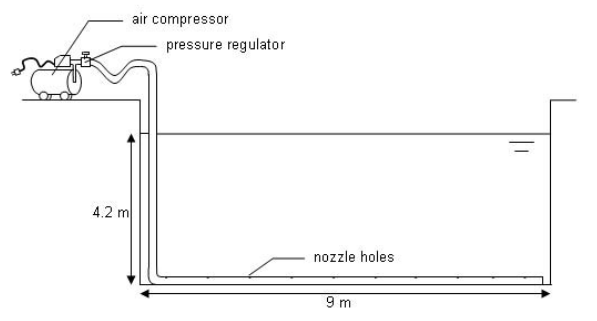
Fig. 5. Situation sketch for the measurements in the lock near